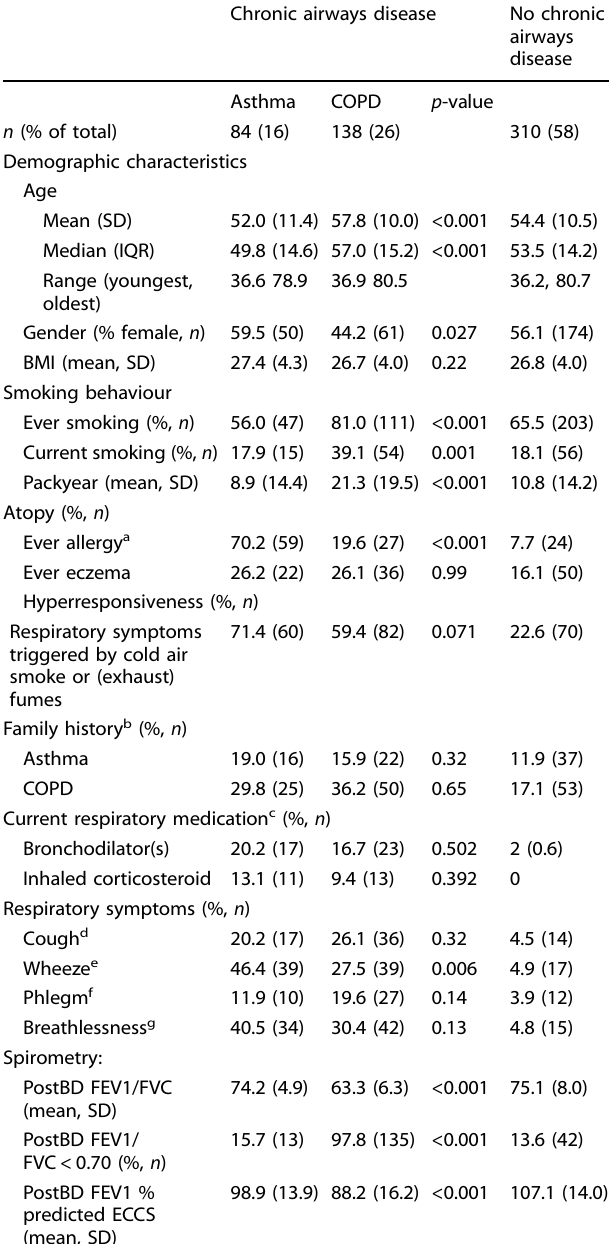
Table 1. Clinical features and lung function values of patients diagnosed with asthma and patients diagnosed with